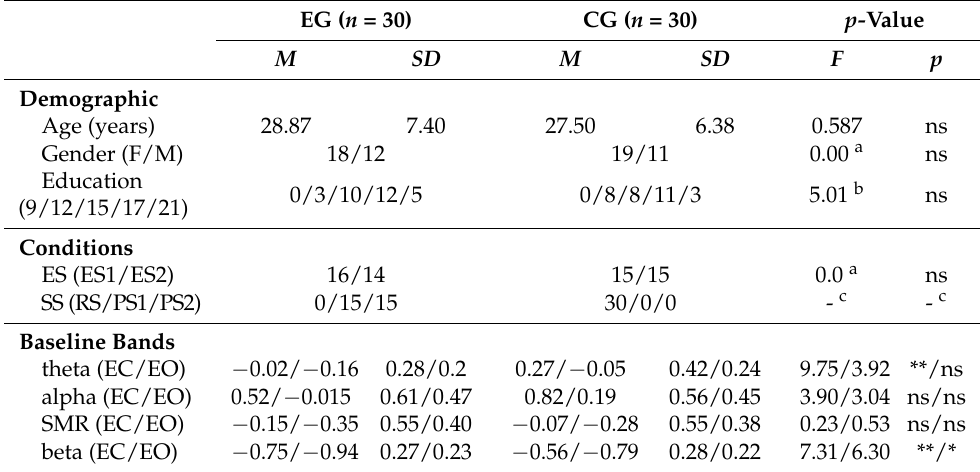
Table 1. Group characteristics at preintervention (T0) (for n = 60).